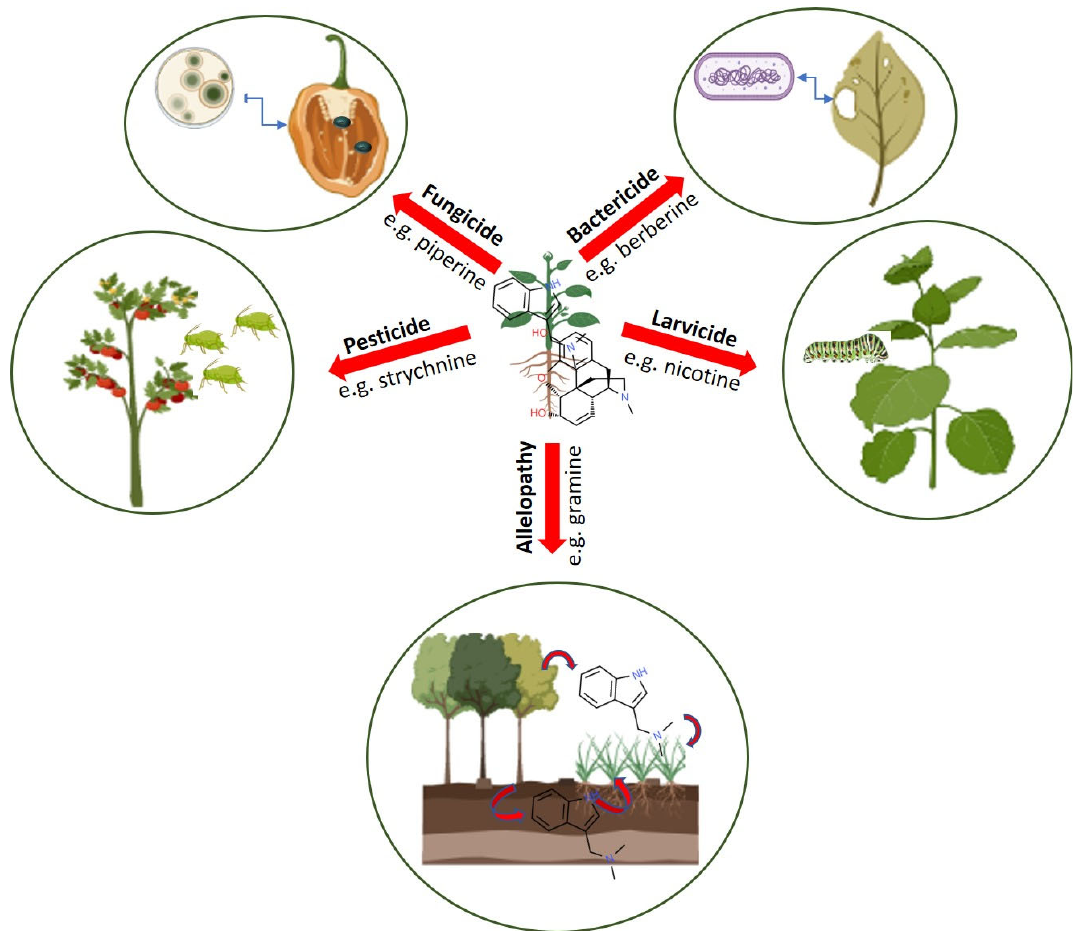
Figure 4. The role of alkaloids in plant defense. Alkaloids produced in different plant tissues, such as leaves, roots, bark, and seeds, are transported to local tissues for fighting against various predators such as pests, fungi, bacteria, and insect larvae, providing plants with protection against these predators. Alkaloids also stop the growth of other plants in the vicinity (allelopathy). Individual images of plant and predators are retrieved from BioRender (BioRender.com) (accessed on 20 March 2021).